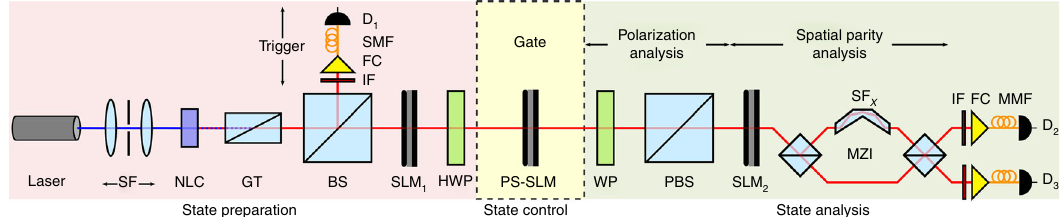
Fig. 4 Schematic of experimental setup. SF: spatial fi lter, NLC: nonlinear crystal, GT: Glan – Thomson polarizer, BS: beam splitter, SLM: spatial light modulator, HWP: half-wave plate, WP: wave plate (either half-wave or quarter-wave according to the measurement basis), PBS: polarizing beam splitter, SF x : spatial fl ipper along x , MZI: Mach – Zehnder interferometer, IF: interference fi lter, FC: fi ber coupler, MMF: multi-mode fi ber, SMF: single-mode fi ber, D 1 and D 2 : single-photon-sensitive detectors. See Supplementary Note 2 for a more detailed setup layout. The spatial fl ipper — implemented by a parity prism — in the MZI is varied according to the measurement basis (Supplementary Note 3). All measurements are carried out by recording the detection coincidences between D 1 and D